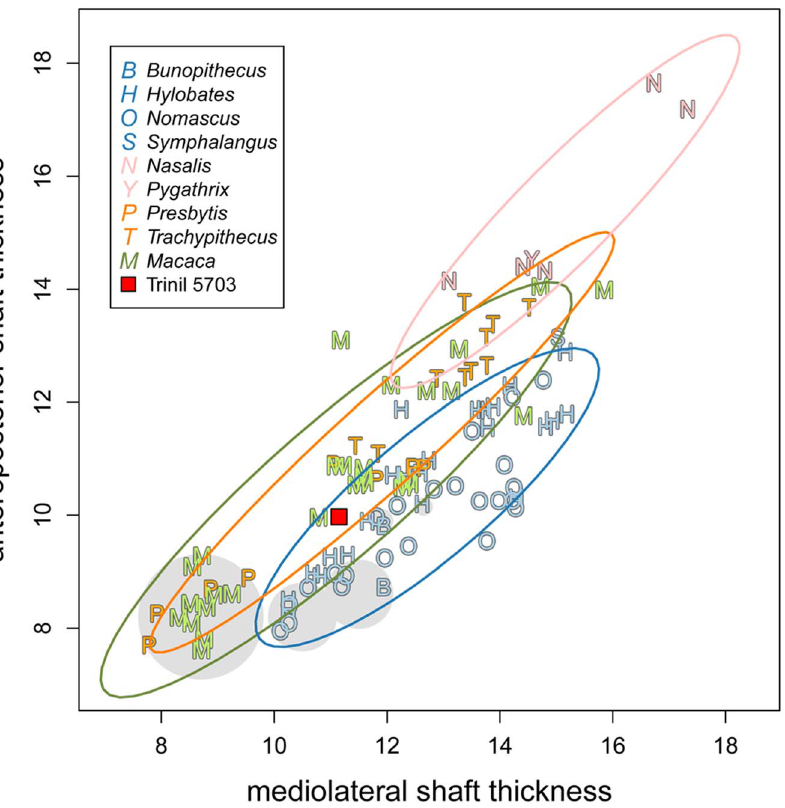
Figure 8. Antero-posterior and mediolateral shaft thickness below the lesser trochanter of Trinil 5703 and comparative sample. Presentation conventions are the same as in Figure 7.